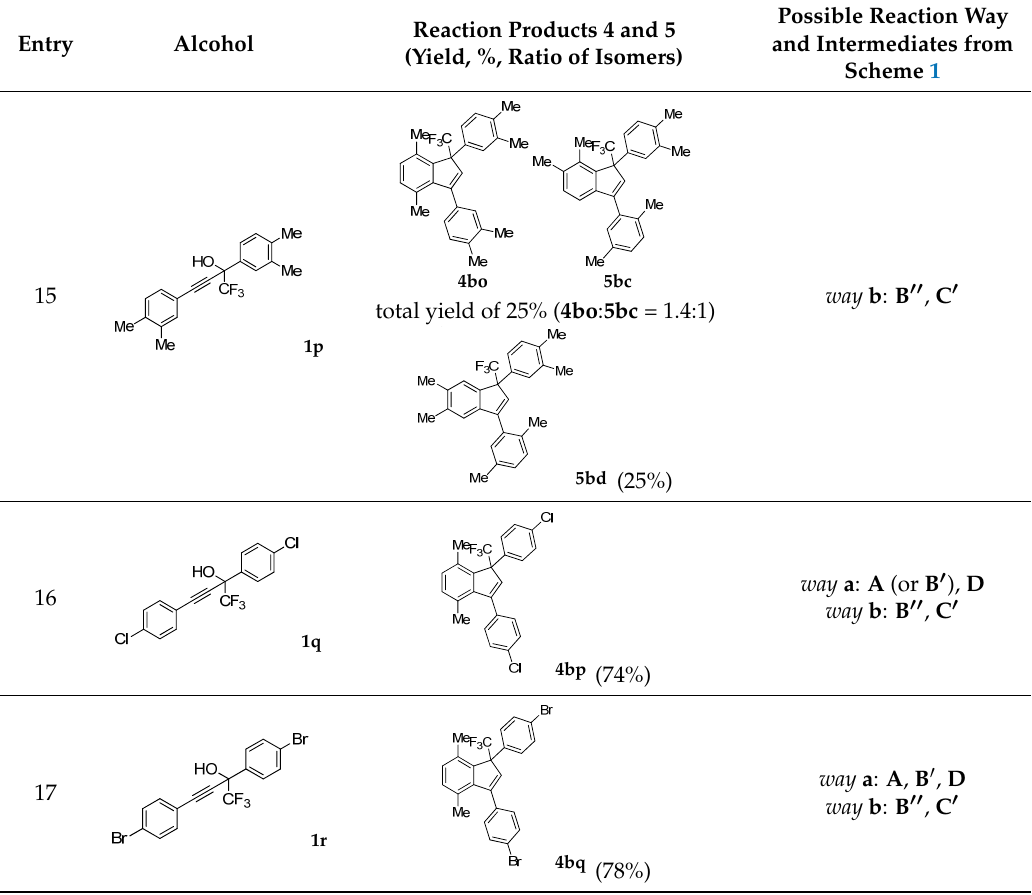
Possible Reaction Way and Intermediates from Scheme 1